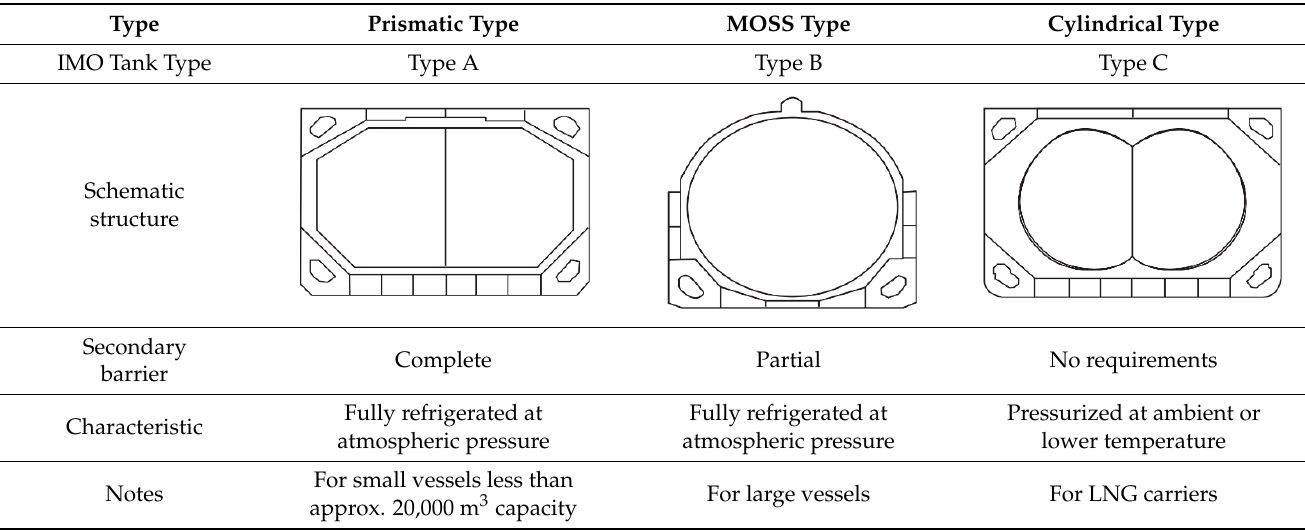
Table 1. IMO independent type tanks for LNG ship [14].